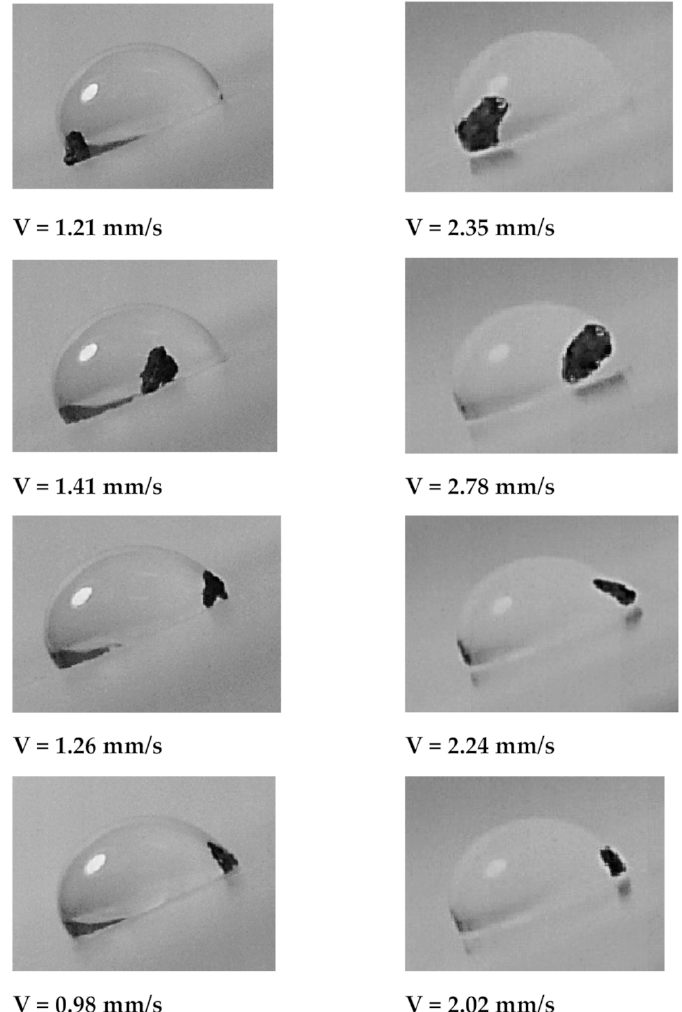
Figure 10. Stages of the droplet on inclined oil film for two oil film thicknesses. The dark color represents the dust